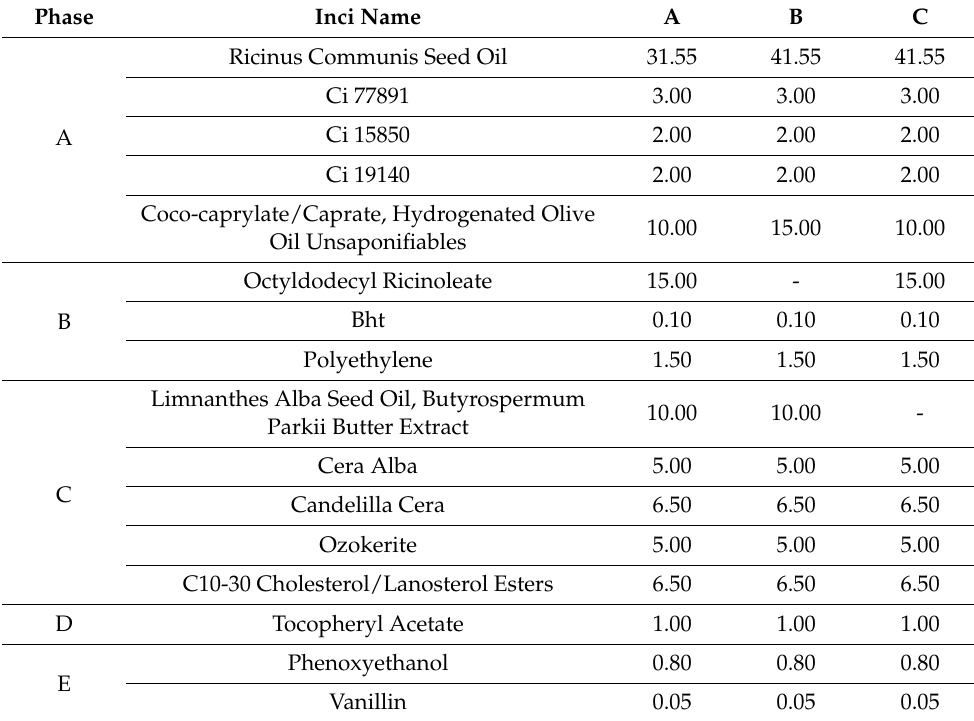
Table 8. Lipstick formulae with the new oil